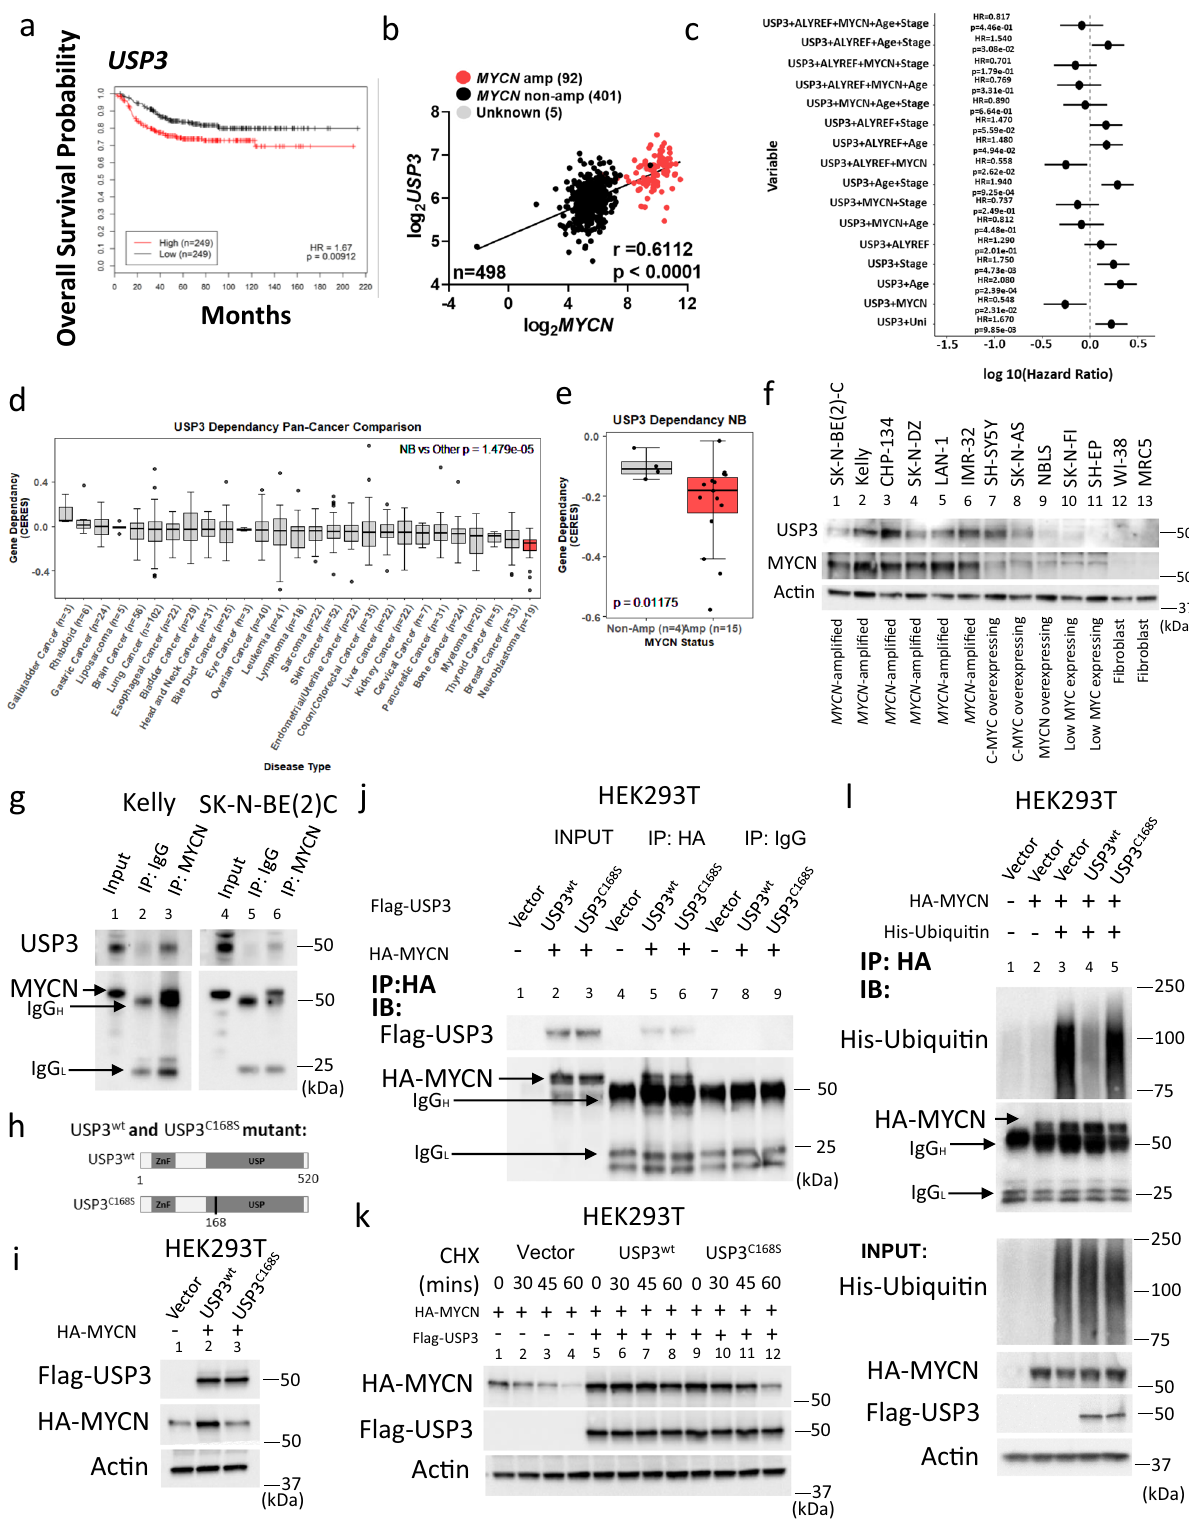
upstream of the BR/HLH/LZ domain in the primary amino acid (AA 281 – 345) and the two proteins form a trans-activator sequence, but as the structure has not been fully solved for MYC complex to regulate USP3 expression. The function of this proteins, the function and position of MYCN AA 281 – 345 in the domain in MYCN and MYC is still understudied. MYC proteins secondary or tertiary structure are unknown. As MYCN showed contain two highly conserved MYC boxes (MYC box III and dependency on ALYREF for ef fi cient induction of USP3 expres- IV) 51 – 53 in the central portion, with suggested roles in regulating sion and the two proteins interact via DNA looping, we argue that DNA binding 54 . The ALYREF-binding site on MYCN lies just NATURE COMMUNICATIONS| (2021) 12:1881